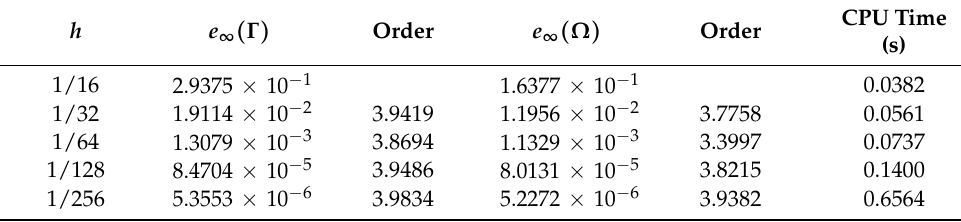
Table 2. Numerical convergence orders of the fourth-order fast algorithm with k 0 = 8 π m − 1 , ε r = 4 + i.